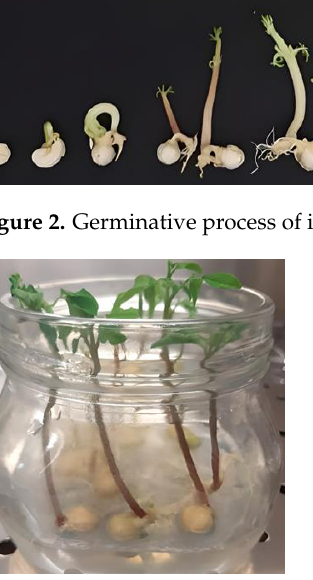
Figure 3. Moringa sprouts growing in a glass